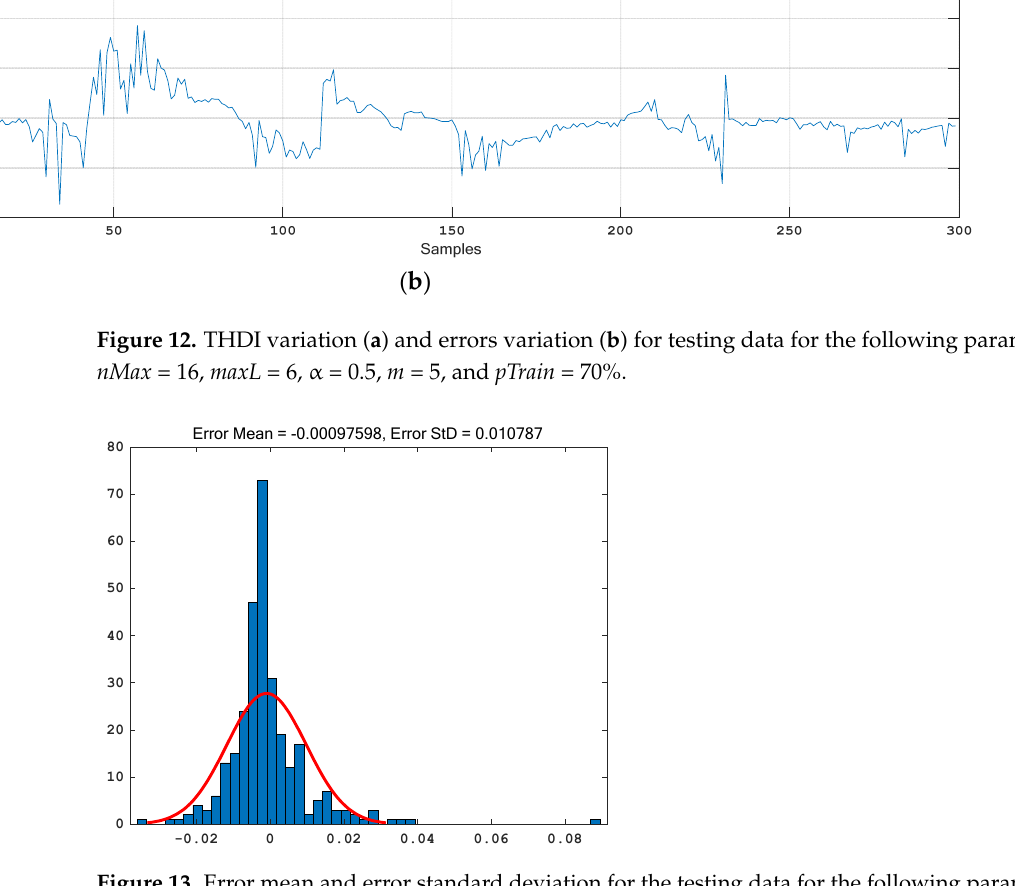
Figure 13. Error mean and error standard deviation for the testing data for the following parameters: nMax = 16, maxL = 6, α = 0.5, m = 5, and pTrain = 70%.